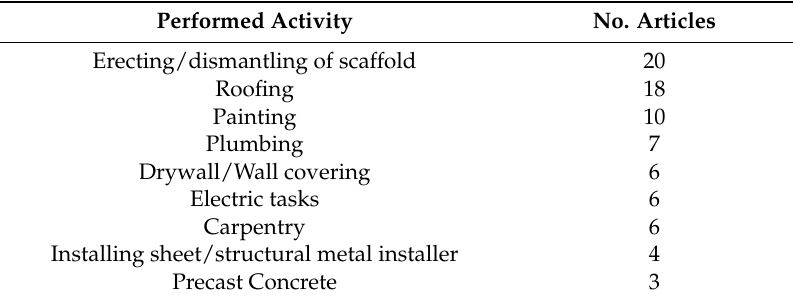
Table 4. Construction activities lead to FFH.